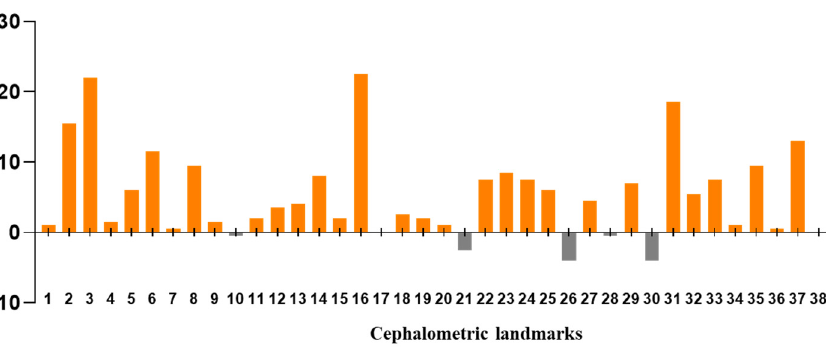
Figure 3. Benefit of beginner–AI collaboration in the detection of cephalometric landmarks. Based on successful detection rate for each landmark within a 2 mm threshold, the benefits of beginner–AI collaboration were analyzed. In general, this collaboration showed a positive impact on the majority of cephalometric landmarks.